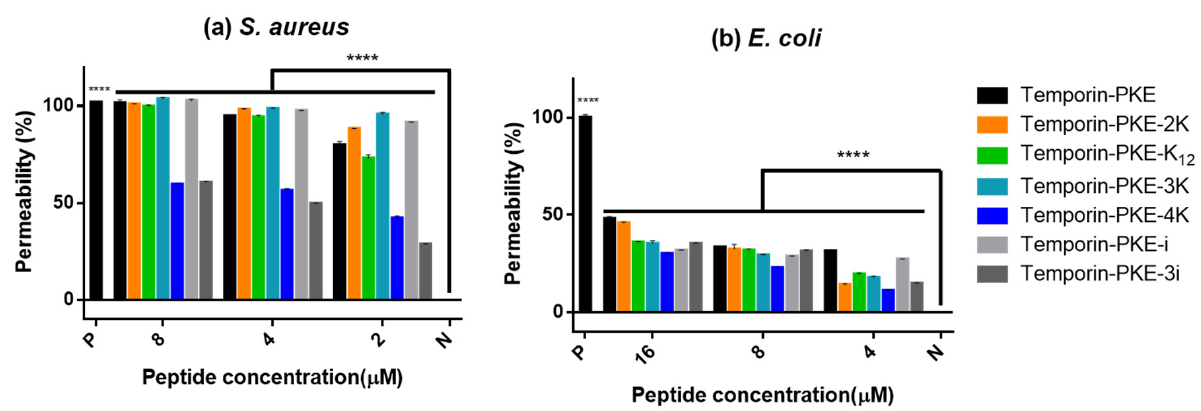
Figure 9. The membrane permeability of temporin-PKE and its analogues against ( a ) S. aureus and ( b ) E. coli . N represents the negative control, which is 5% TSB in 0.85% NaCl and 5% LB in 0.85% NaCl, respectively. P represents the positive control, which is 8 µ M mellitin and 70% Isopropanol, respectively. The results were analysed by two-way ANOVA and Dunnett’s multiple comparisons test compared the cell viability of different concentrations of peptides with that of the negative control group. The significance is indicated by **** which means p < 0.0001. The error bar represents the SEM of the nine replicates from three independent tests.